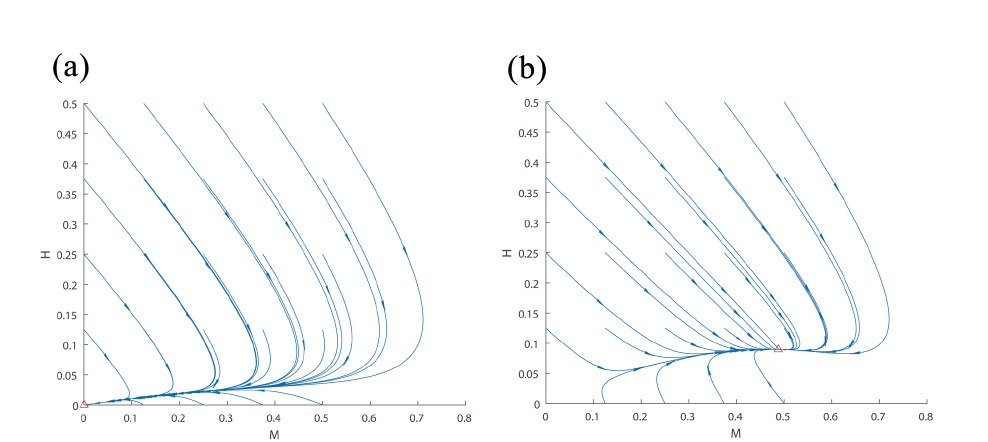
Figure 3. Two-dimensional phase diagrams of ( y , z ) trajectories. ( a ) Every ( y , z ) line at different initial conditions approaches the origin with R 0 = 0.47. The diminishing of the Medium- and High-risk areas illustrates the effective control of COVID-19. ( b ) The ( y , z ) lines converge to a non-zero point ( 0.48,0.09 ) at R = 2.37, which agrees with the previous proof of a stable endemic equilibrium when 0 R 0 > 1.